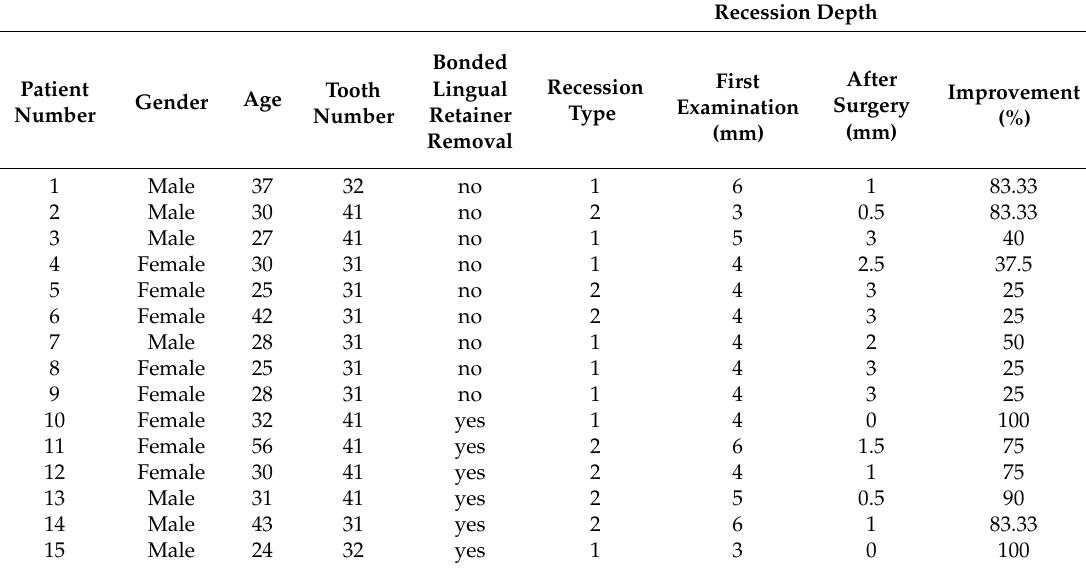
Table 1. Description of patients who attended the study, including recessions depth (in mm) before and after the surgery. Recession type following Cairo et al.